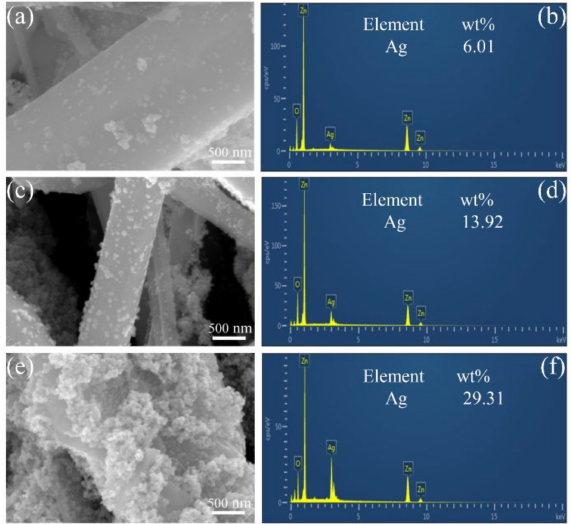
Figure 3. ( a , c , e ) SEM images of ZnO/Ag. ( b , d , f ) EDS spectra of ZnO/Ag.